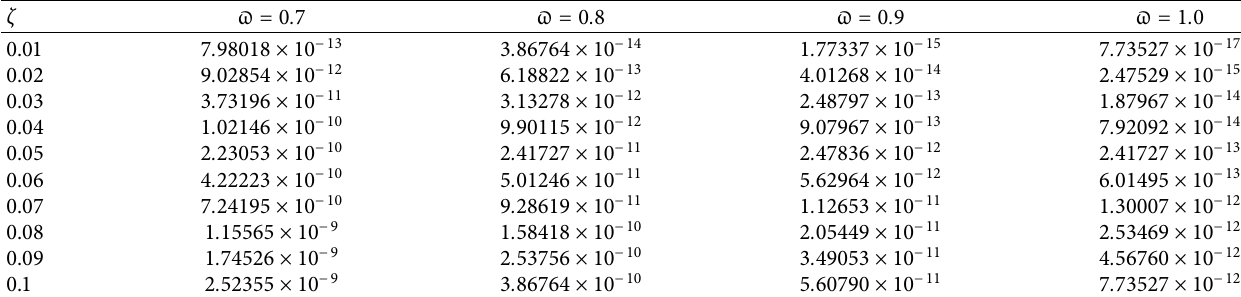
Table 2: | w 5 ( ϰ , ζ ) − w 4 ( ϰ , ζ )| of Problem 1 at diferent values of ϖ at ϰ � 0 . 002 determined by LRPSM at plausible locations in the range ζ ∈ [ 0 , 0 . 1 ]